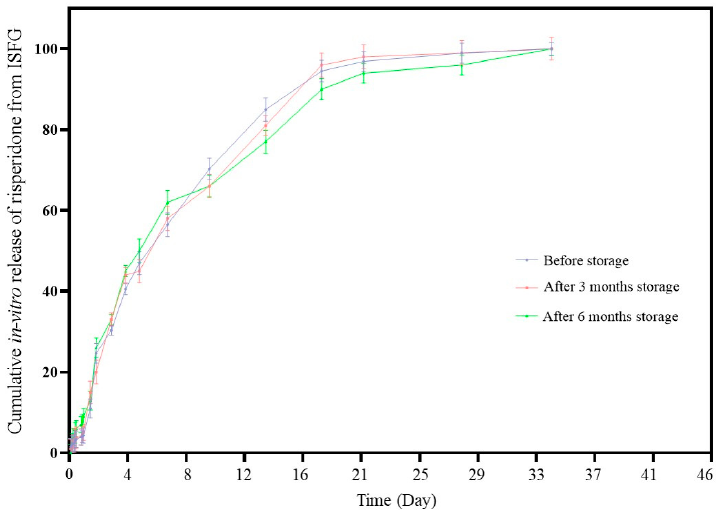
Figure 8. The release profile of ISFG formulation at different times (0, 3rd and 6th months) under accelerated stability test